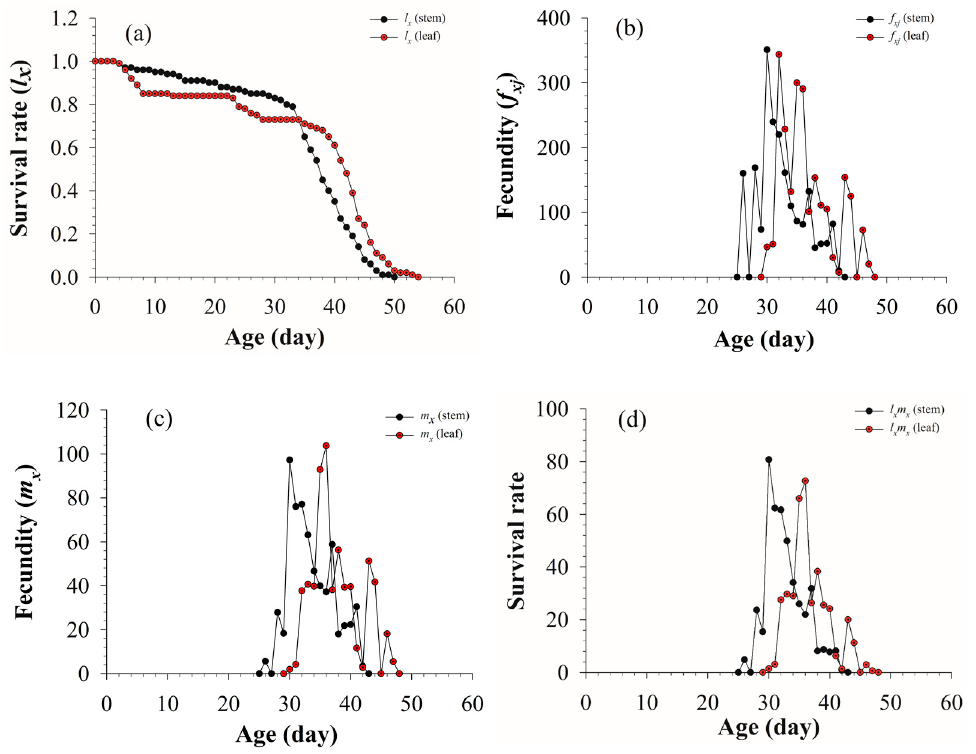
Figure 2. Population survival rate ( l x ) ( a ), fecundity of female adult ( f xj ) ( b ), population fecundity ( m x ) ( c ), and population maternity ( l x m x ) ( d ) of S. litura fed on different tissues of asparagus.